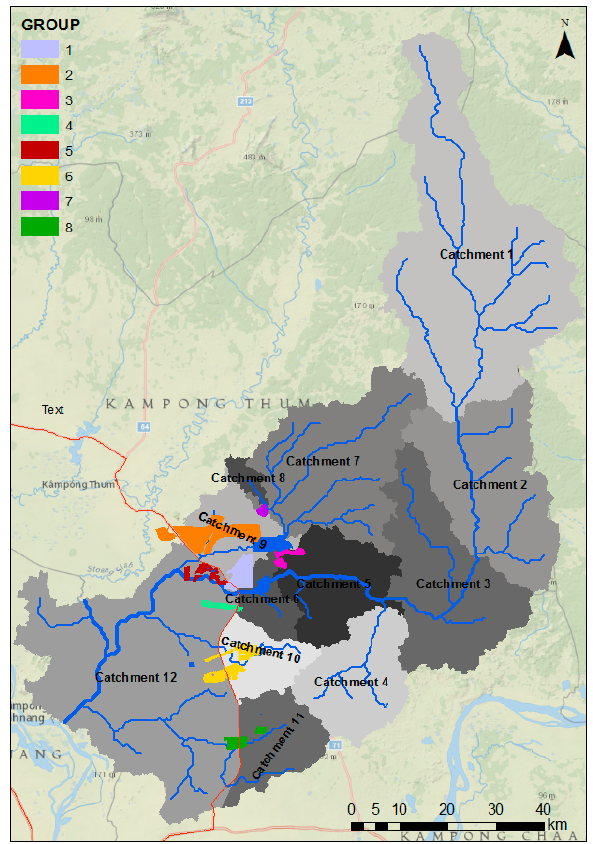
Figure 2. Map of the Stung Chinit watershed, divided into 20 WEAP catchments, with non-irrigated catchments shown in grey and irrigated catchments in color.